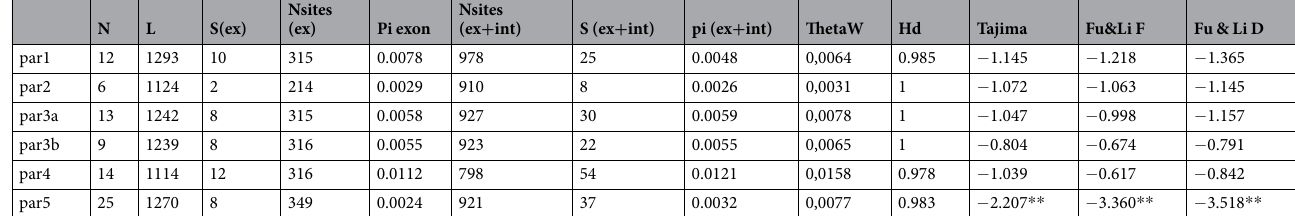
Table 1. Genetic diversities and associated statistical tests for the six preproalvinellacin paralogs of Alvinella pompejana . N: number of sequences; L: length of the paralog. S: number of polymorphic sites in both exonic (ex) and entire region (ex + int), Nsites: effective length of each domain, Pi: nucleotide diversity, ThetaW: Theta Watterson, Hd: Haplotypic diversity, Tajima: Tajima’s D test, Fu&Li F: Fu and Li’s F test, Fu&Li D: Fu and Li’s D test. Statistical significance: ** for P < 0.05.